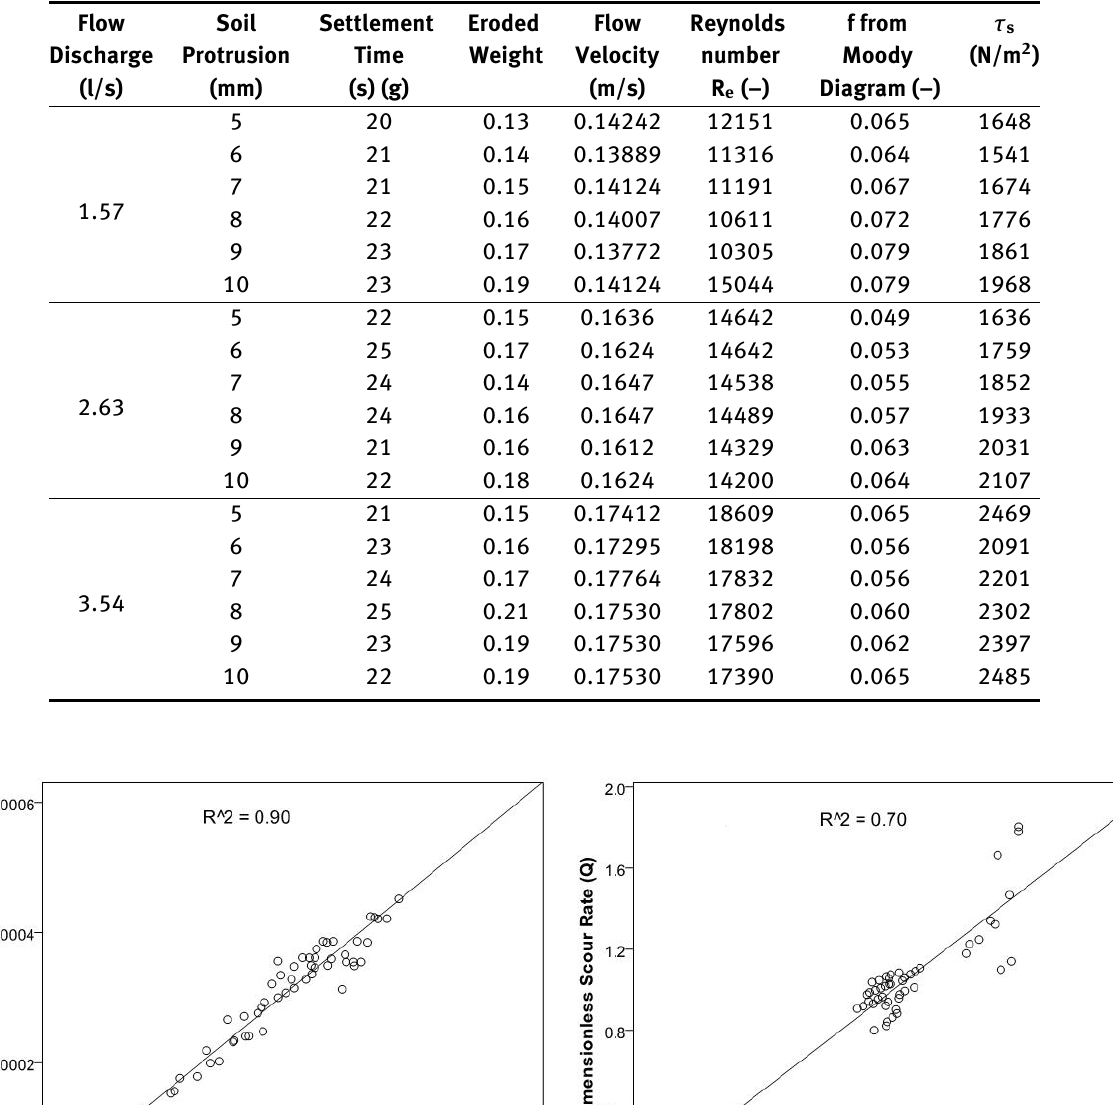
Table 5: Sample calculation table for d 50 = 0.15mm soil sample under three different flow discharges